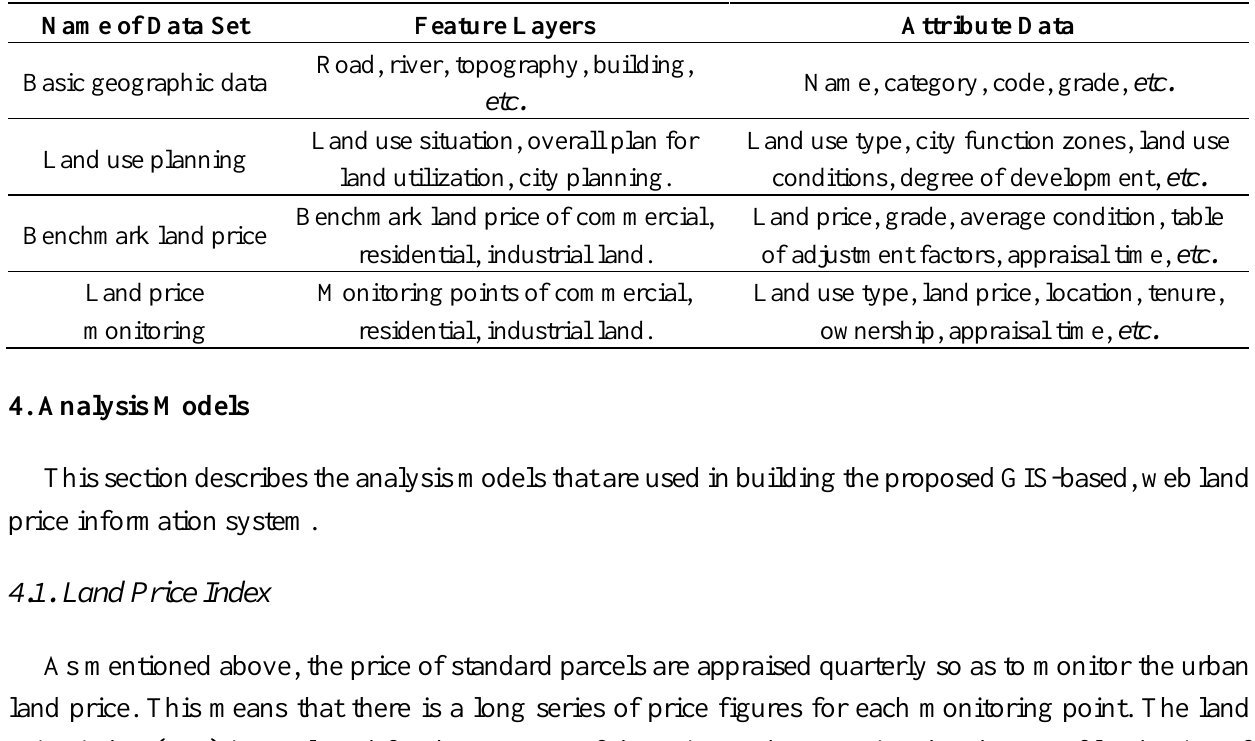
Table 1. Data sets for serving land price